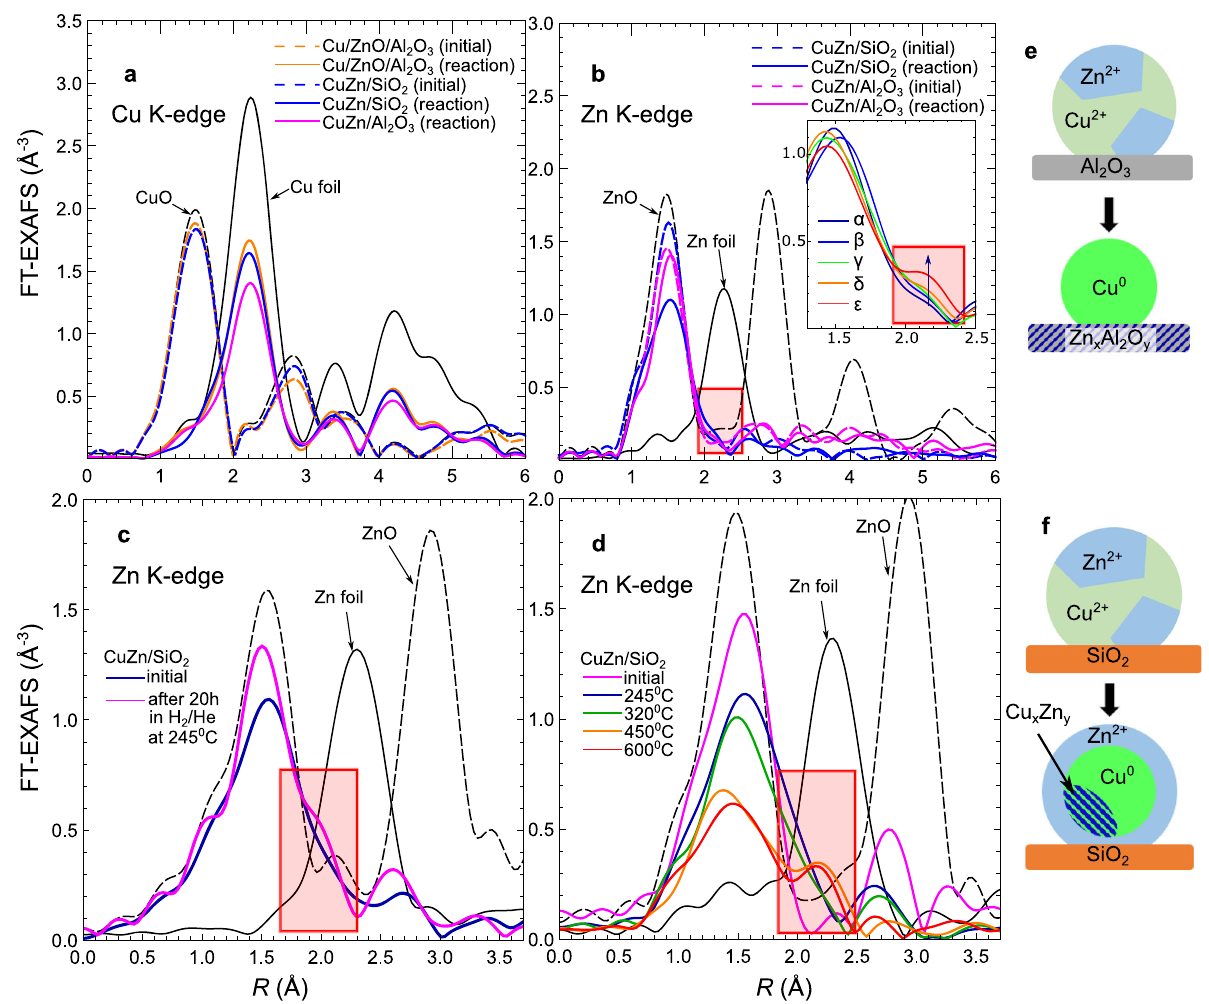
Fig. 3 Operando Cu K-edge and Zn K-edge EXAFS spectra. The FT magnitude of the a Cu K-edge and b Zn K-edge EXAFS spectra for Cu/ZnO/Al 2 O 3 , CuZn/SiO 2 , and CuZn/Al 2 O 3 catalysts in their initial state (dashed lines), and under operando conditions in CO 2 + CO + H 2 , p = 20 bar, T = 220°C (solid lines). The magnitude of the FT of the EXAFS spectra for CuZn/SiO 2 during c a reduction in 10% H 2 /He for 20 h at 245°C and d at temperatures between 245 and 600°C. The reference spectra for a Zn foil, ZnO, CuO, and Cu foil are also shown. The highlighted areas in b – d indicate the region where the Zn – M bond develops under reaction conditions. The latter is also shown in the inset in b , with spectra α , β , γ , δ , and ε corresponding to consequent measurements at 220°C/20 bar, 280°C/20 bar, 280°C/40bar, and 320°C/40bar. To enhance the display of the referred features, different k-ranges were used for the Fourier transform in a , b 1 – 10.5 Å − 1 , c 3 – 12 Å − 1 , and d 1 – 10 Å − 1 . The observed changes are schematically presented in e for CuZn/Al 2 O 3 and f for CuZn/SiO 2